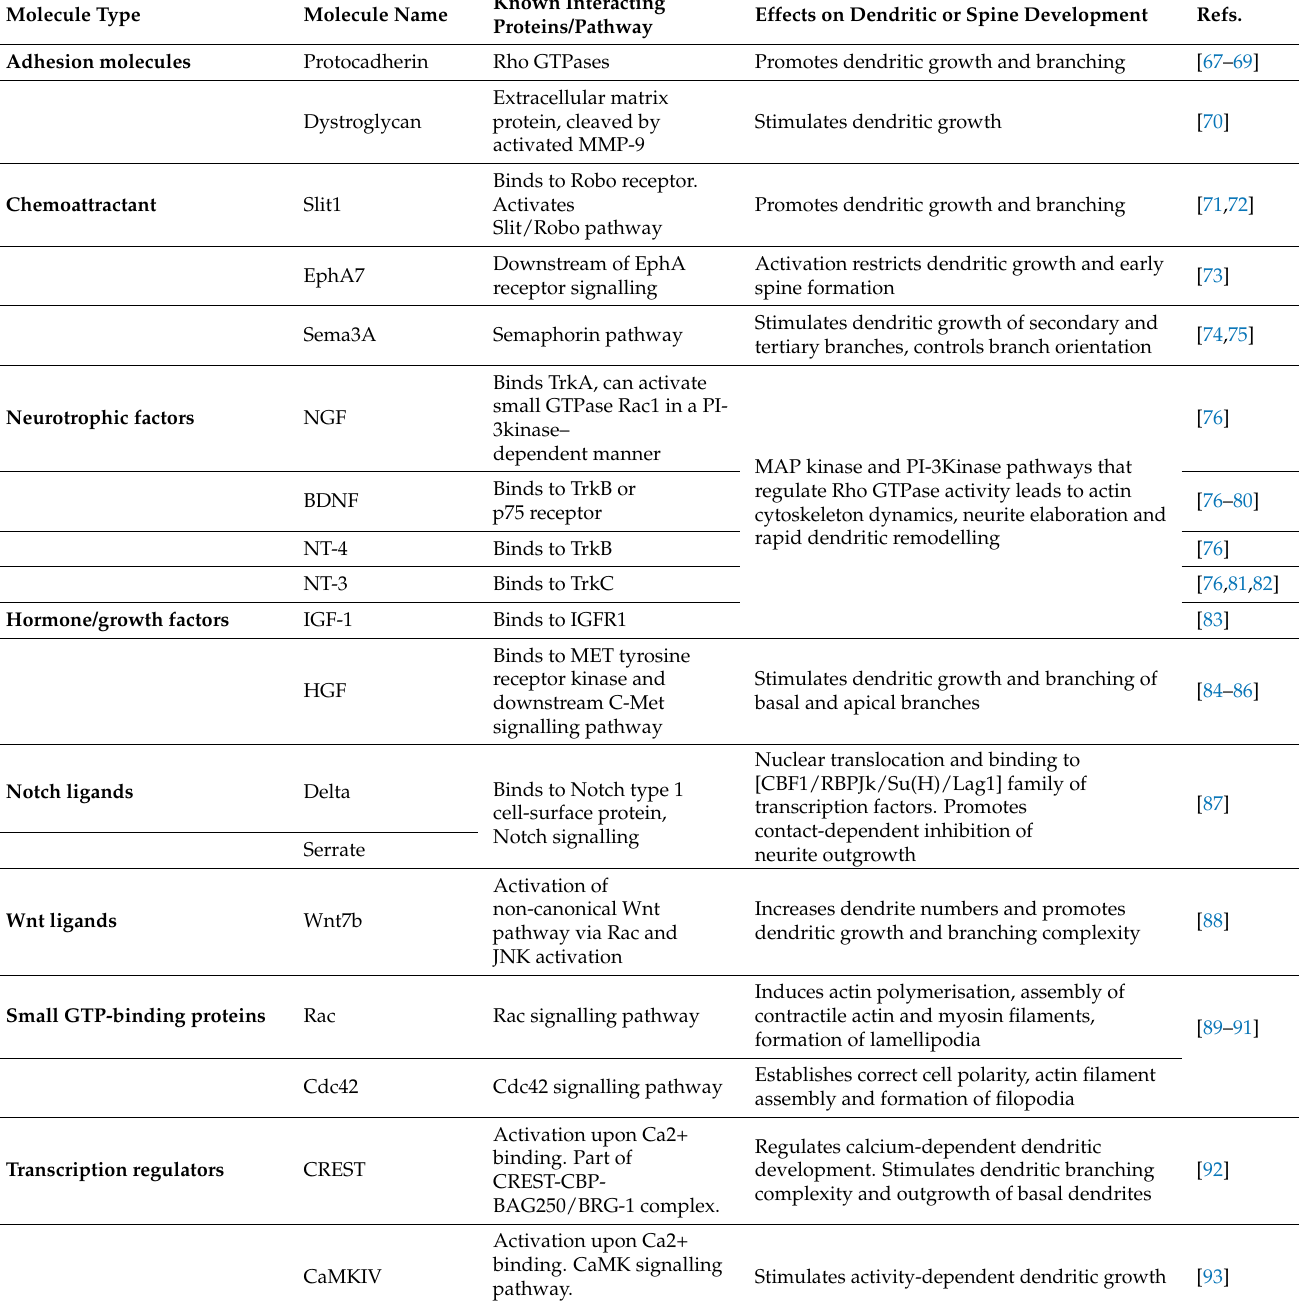
Table 1. Extrinsic regulators of dendritic arborisation and spine